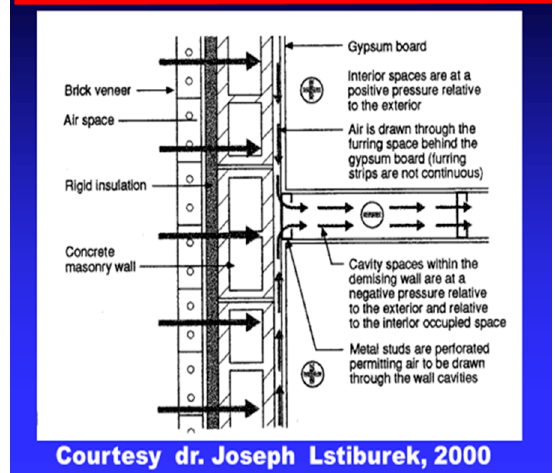
Figure 3. Interstitial airflow results in mold growth on the interior in a Florida hotel Reprinted with permission of dr. J. W. Lstiburek.